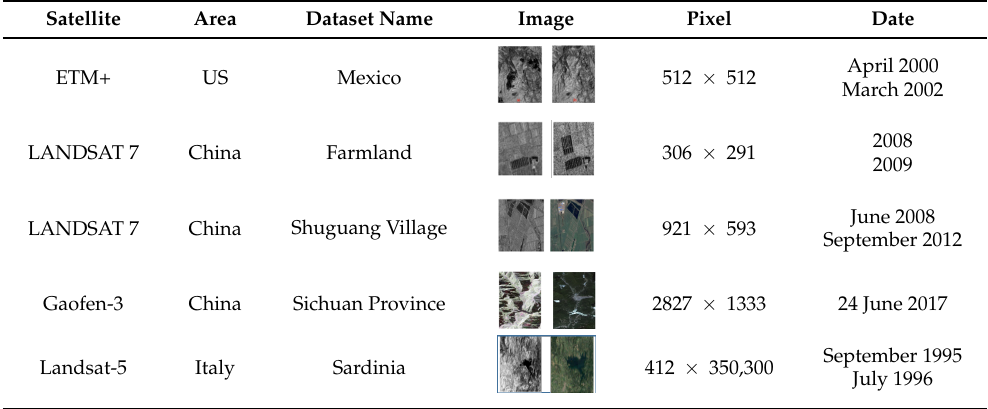
Table 8. Illustration of Heterogeneous